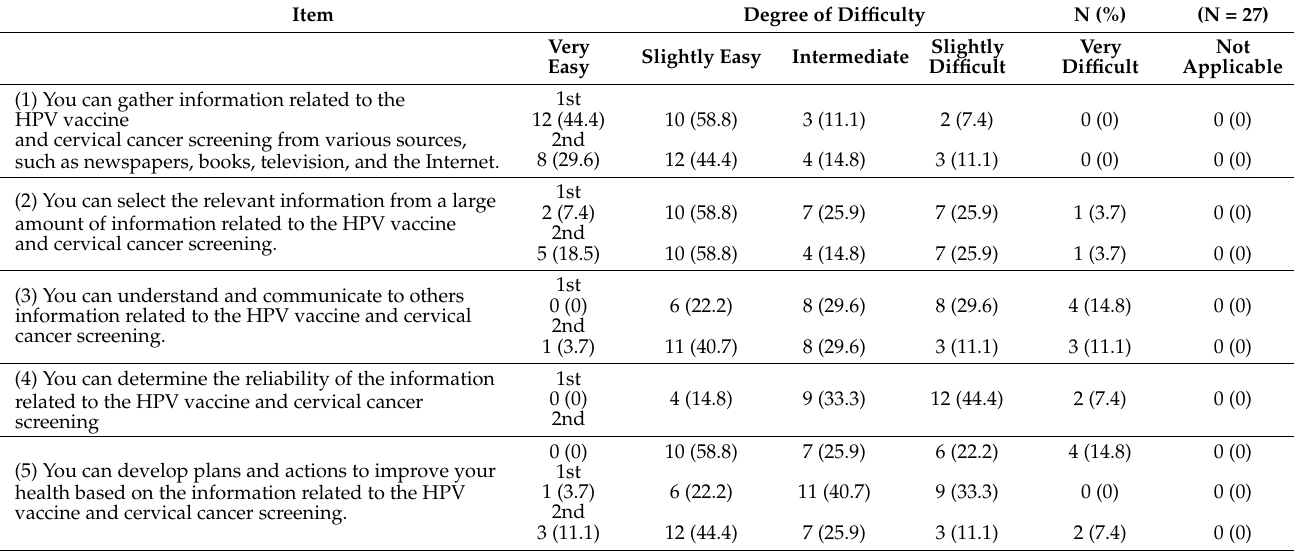
Table 3. Results of the communicative and critical health literacy scale (first and second sur- vey